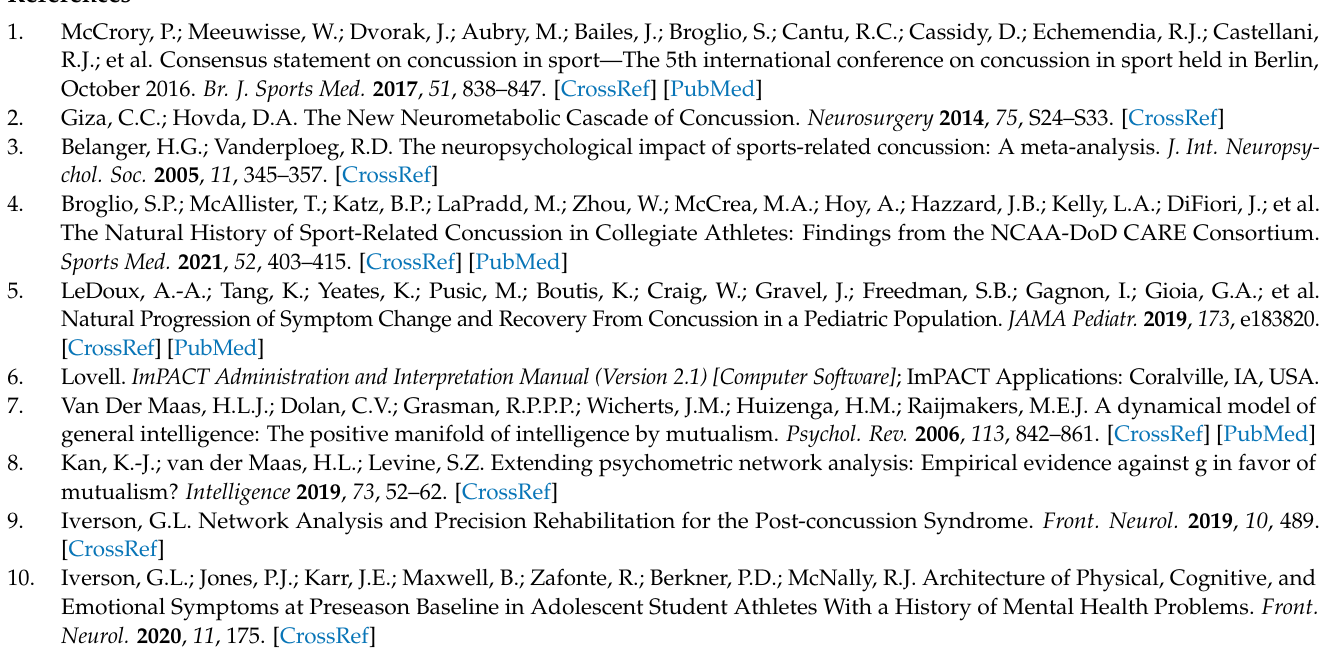
tion; Figure S2: Estimated Node Strength and Expected Influence Over Time; Figure S3: Ordered Node Strength Centrality Values at Each Time Point; Figure S4: Ordered Node Expected Influence Values at Each Time Point; Figure S5: Average Correlations Between Centrality Indices of Networks Sampled with Persons Dropped and Original Sample; Figure S6: Bootstrapped Confidence Intervals of Estimated Edge-Weights for Each Network; Figure S7: Bootstrapped Difference Tests Between Edge-Weights That Were Non-Zero in the Estimated Networks; Figure S8: Bootstrapped Difference Tests Between Node Strength in the Estimated Networks; Figure S9: Bootstrapped Difference Tests Between Expected Influence in the Estimated Networks; Table S1: Means and Standard Deviations of Cognitive Variables; Table S2: Means and Standard Deviations for ImPACT-Generated Composite Scores by Time Point (N =